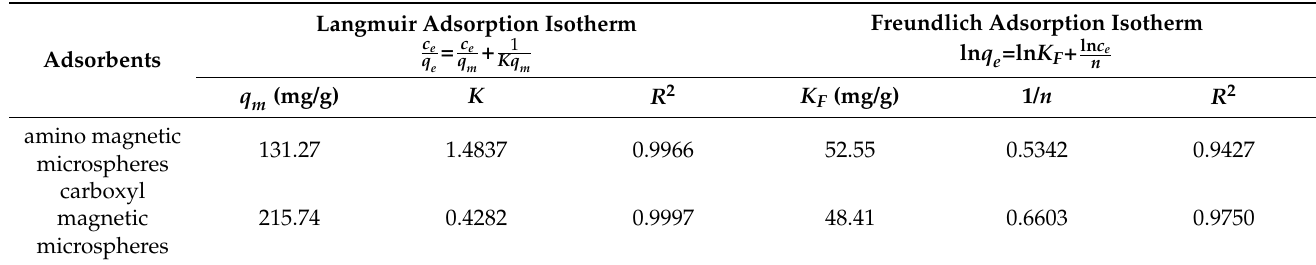
Table 2. The adsorption isotherm parameters of Hb by amino magnetic microspheres and carboxyl magnetic